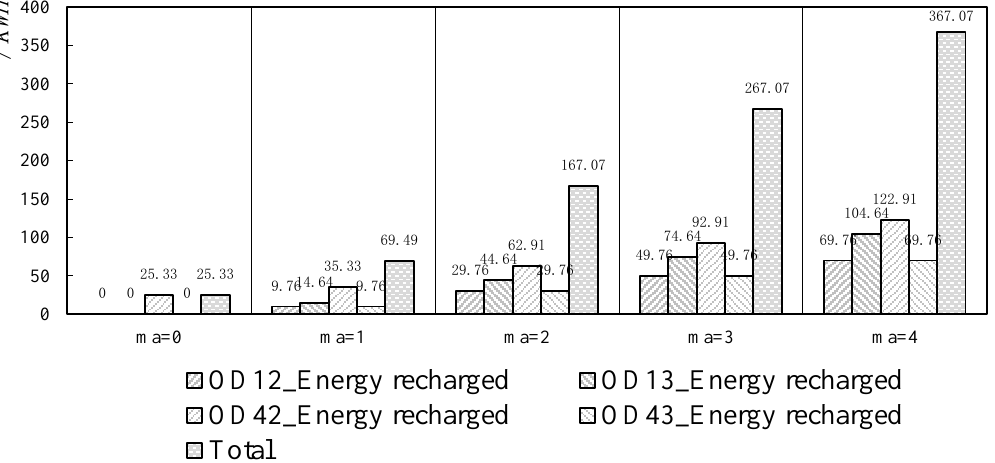
Figure 4. Comparison of the energy recharged for various range anxiety levels.